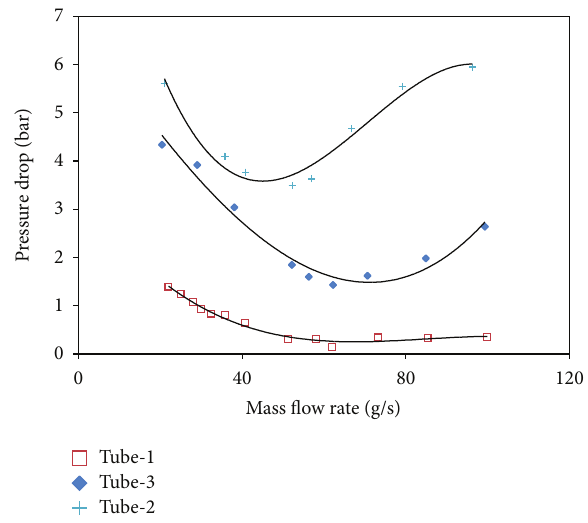
F 7: e comparison of the steady state characteristics for all tubes.